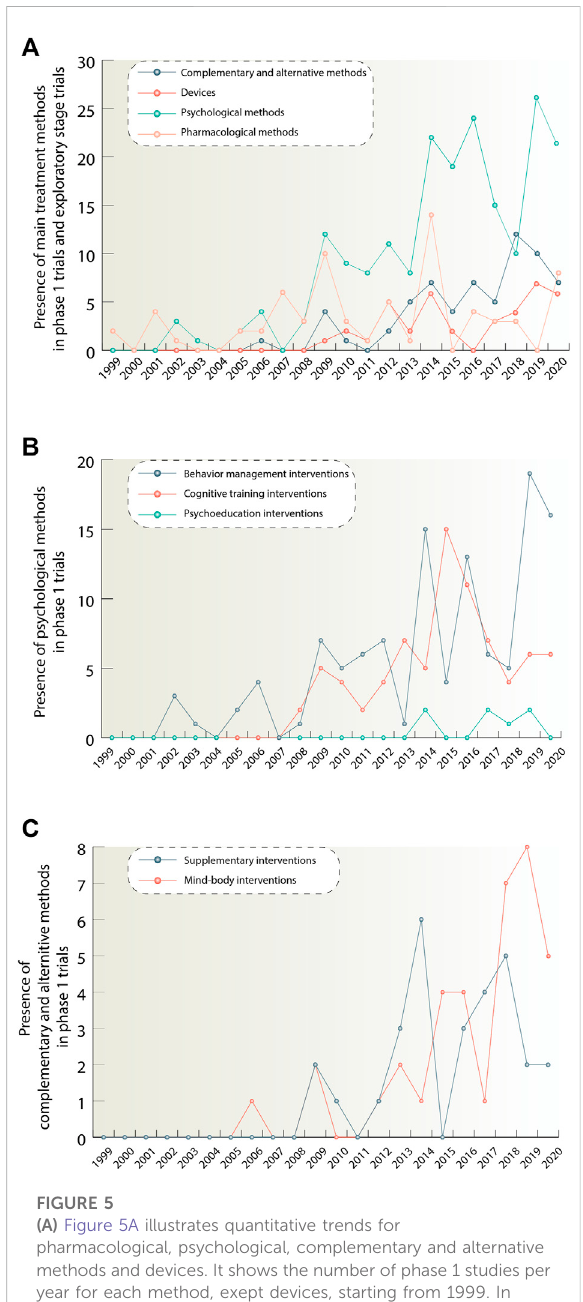
Figure 5C, it can be concluded, that the complementary and alternative methods group consisting of supplementary and mind and body interventions showed 36 interventions in total, while mind and body interventions demonstrated the highest